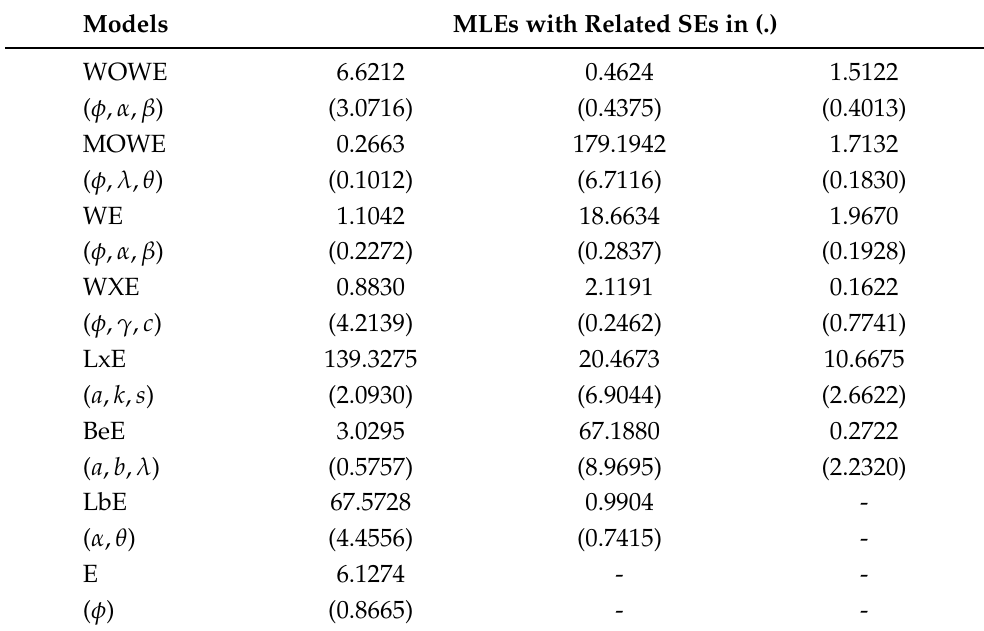
Table 4. MLEs and SEs of the parameters of the considered models for the drilling machine data.